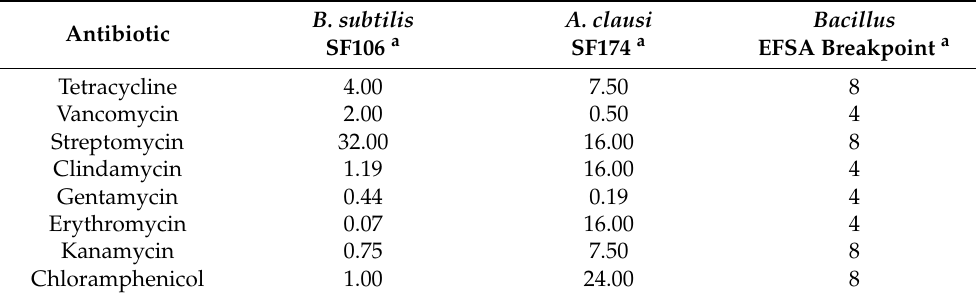
Table 5. Minimal Inhibitory Concentration (MIC) of selected antibiotics against SF106 or SF174. B. Antibiotic